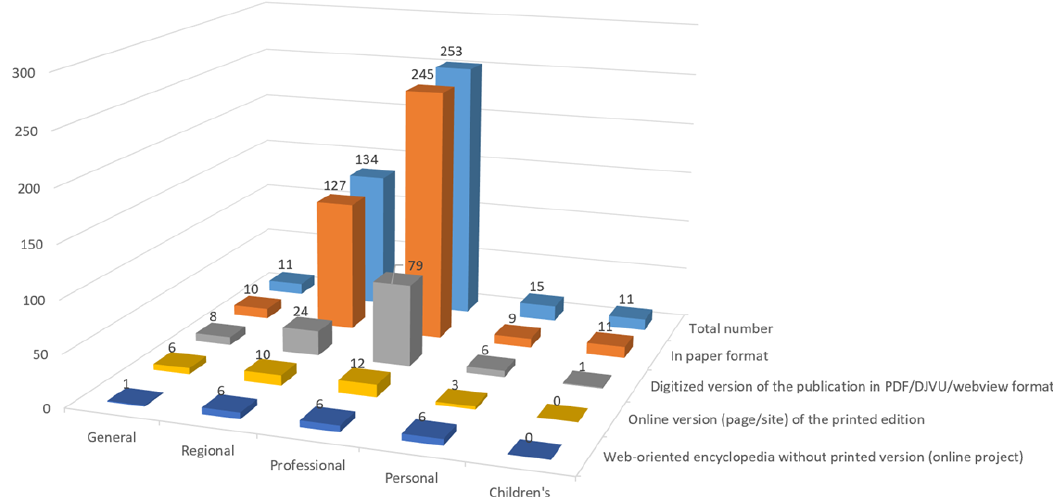
Figure 2: Statistics of Ukrainian encyclopedic editions by types and format of